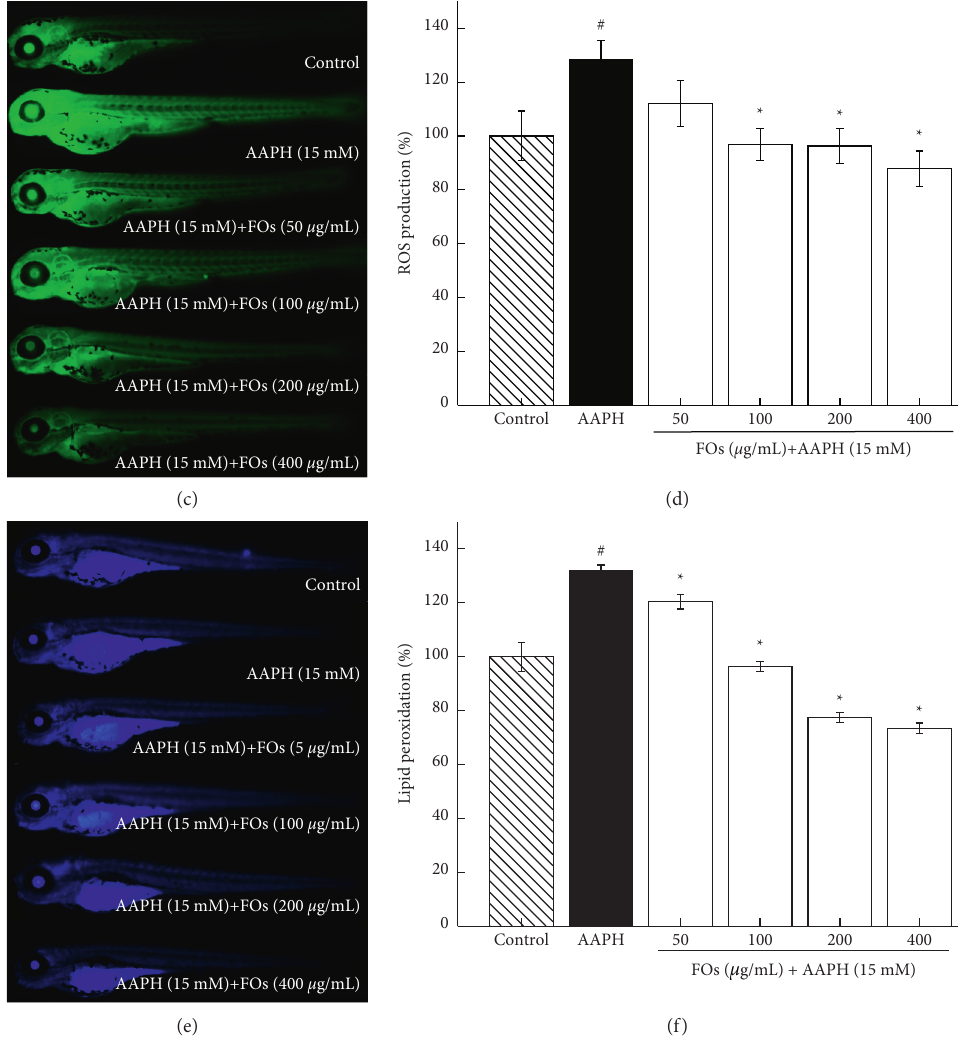
Figure 6: The effects of various concentrations of FOs-FWB on cell death (a, b), ROS generation (c, d), and lipid peroxidation (e, f) in AAPH- stimulatedzebrafish embryosmeasuredby fluorescencemicroscopyandimageJsoftware. Thedata areexpressed asthemean ± SE ( n � 3). # Indicates significant differences from control. ∗ Indicates significant differences from AAPH. FOs-FWB: feruloyl oligosaccharides from fermented wheat